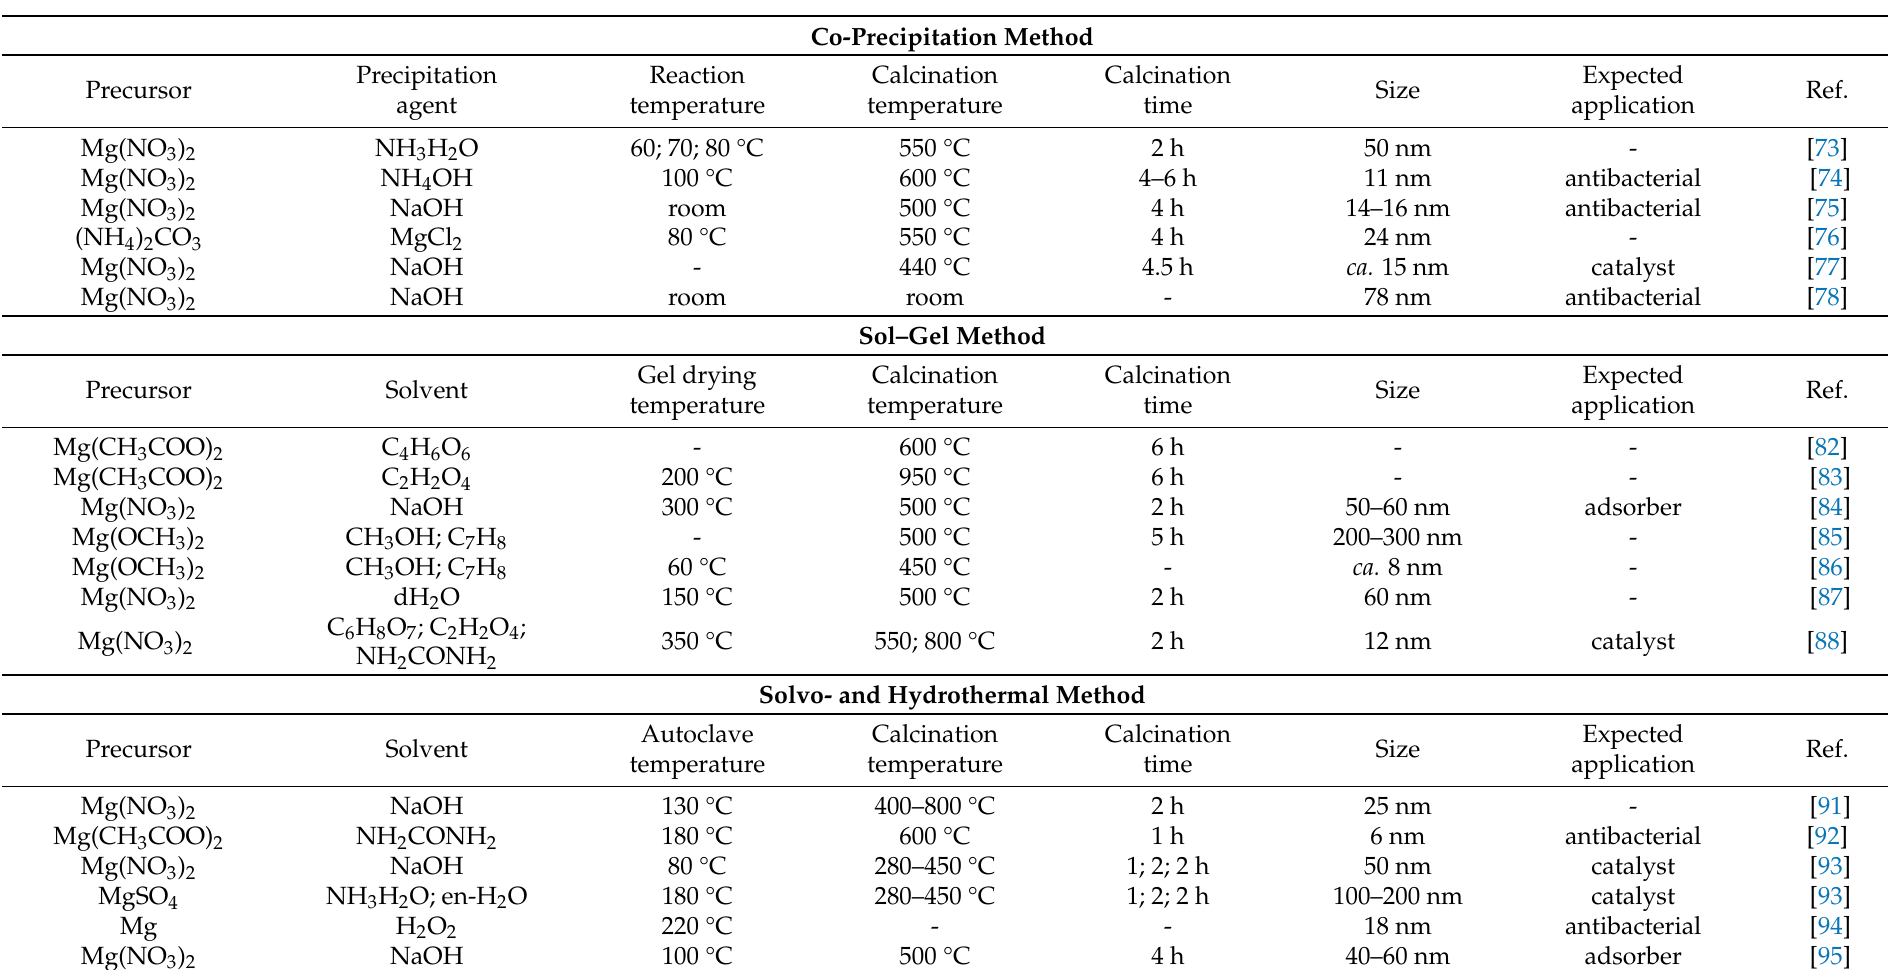
Table 1. Individual substances and reaction conditions for nanostructural MgO synthesis via different methods based on the bottom